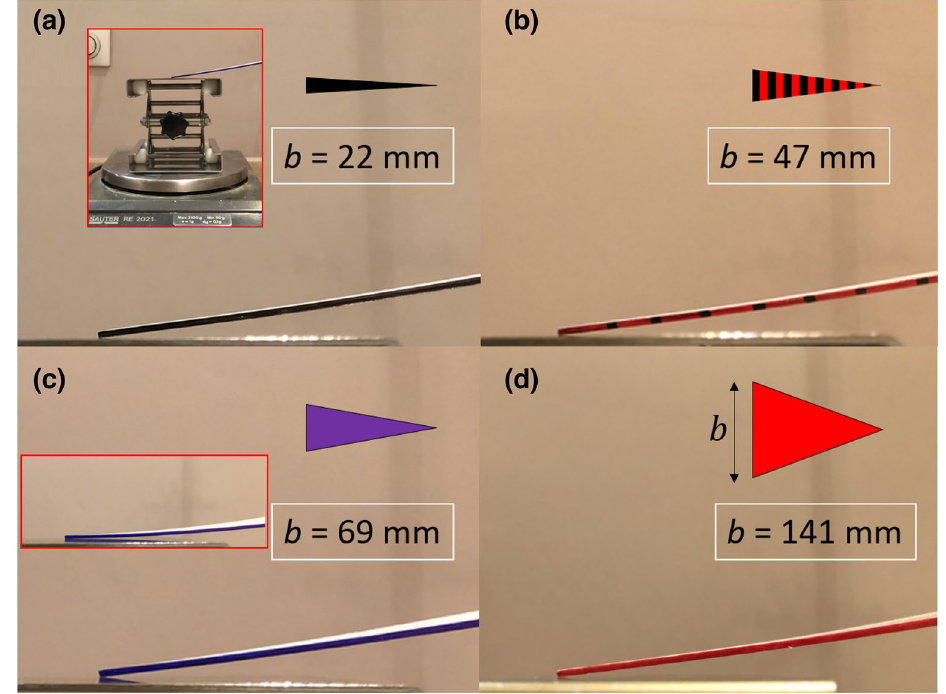
Figure 6. Photographs showing the contact force versus overtravel experiments. The tips of the triangular cantilevers are in contact with the adjustable height laboratory stand (indicated in the inset to ( a ). Photographs are shown for a triangular cantilever base width b of: ( a ) 22 mm, ( b ) 47 mm, ( c ) 69 mm, and ( d ) 141 mm. The inset to ( a ) shows the experimental setup. The inset to ( c ) shows the tip in tangency with the